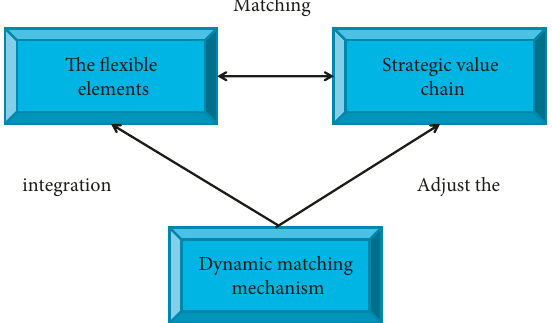
Figure 8: Functional diagram of dynamic matching